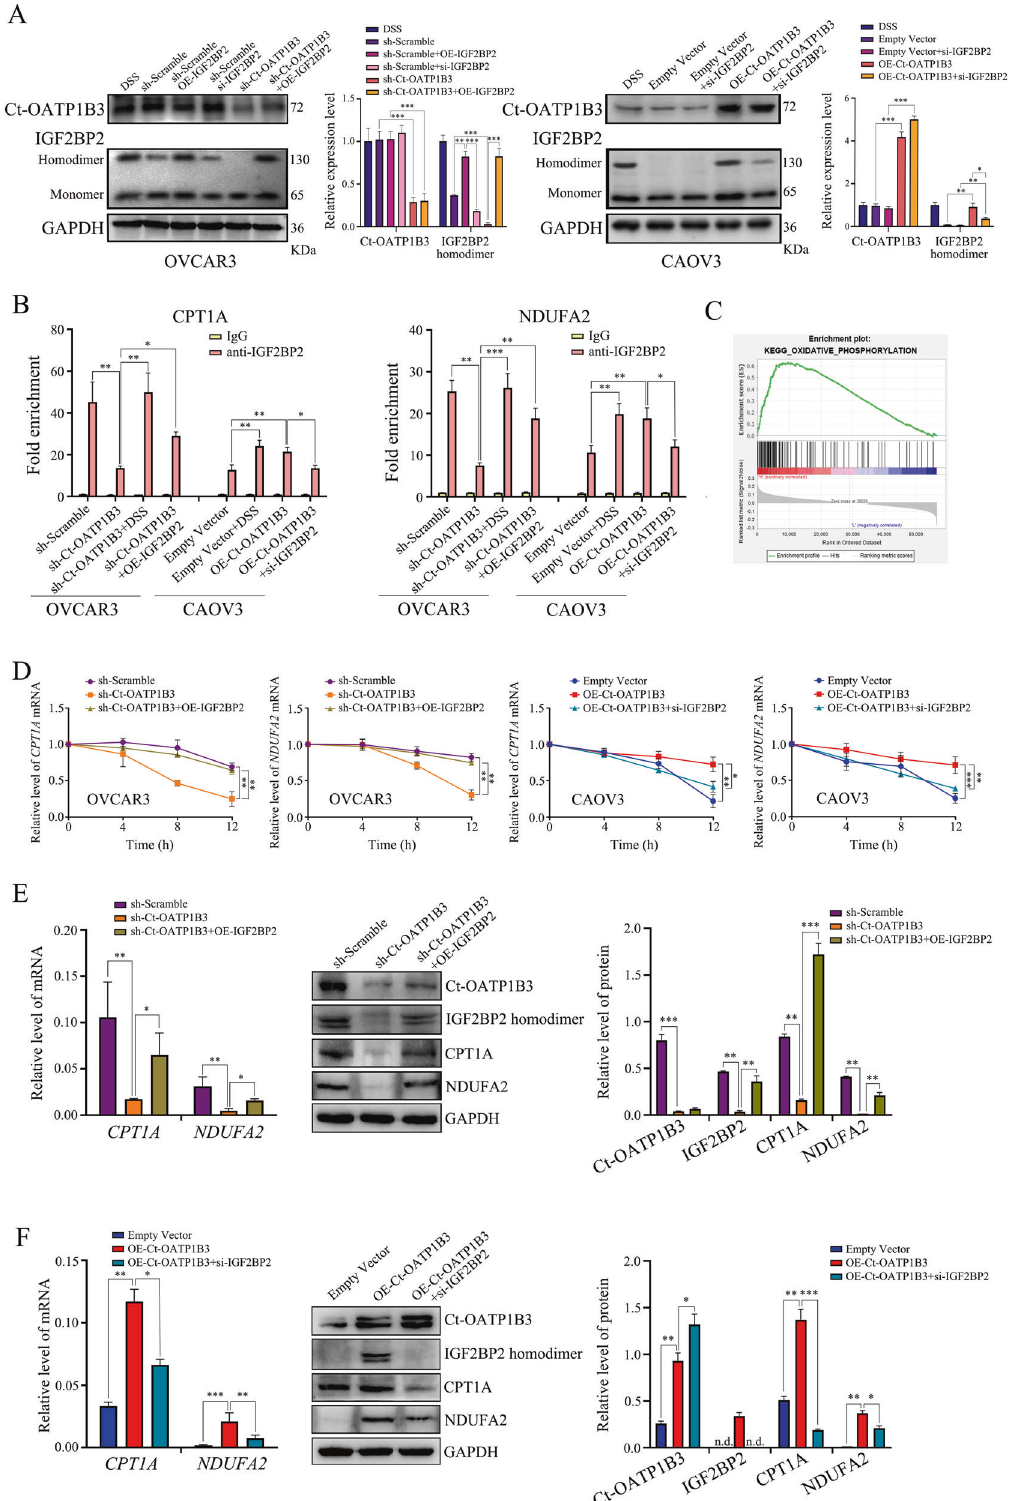
Fig. 5 Ct-OATP1B3 facilitates IGF2BP2 binding to its mRNA targets. A Ct-OATP1B3 promotes the formation of IGF2BP2 homodimer in HGSOC cells. B RIP assay shows Ct-OATP1B3 enhances the binding of IGF2BP2 to its mRNA targets CTP1A and NDUFA2 . C GSEA analysis demonstrates that increased expression of Ct-OATP1B3 in HGSOC tissues is related to the mitochondrial OXPHOS pathway. D Ct-OATP1B3 enhances CPT1A and NDUFA2 mRNA stabilities after actinomycin D treatment. E , F Ct-OATP1B3 enhances CPT1A and NDUFA2 expression in OVCAR3 ( E ) and CAOV3 ( F ) cells. * P < 0.05, ** P < 0.01, *** P < 0.001.